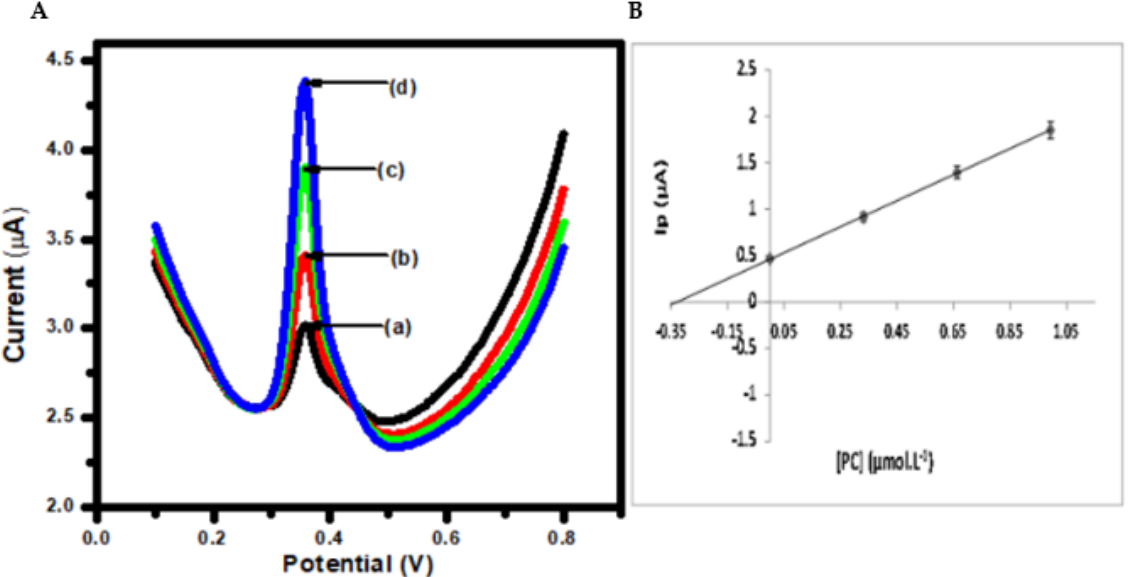
Figure 9. DPV measurements for the recovery of PC on ERGO-SbNPs-PGE with standard additions at different concentrations of sample (a); sample + 0.331 µ mol · L − 1 (b), sample + 0.662 µ mol · L − 1 (c), and sample + 0.993 µ mol · L − 1 (d) PC solution in ( A ), and linear plot of the peak current response of average standards added in ( B ).